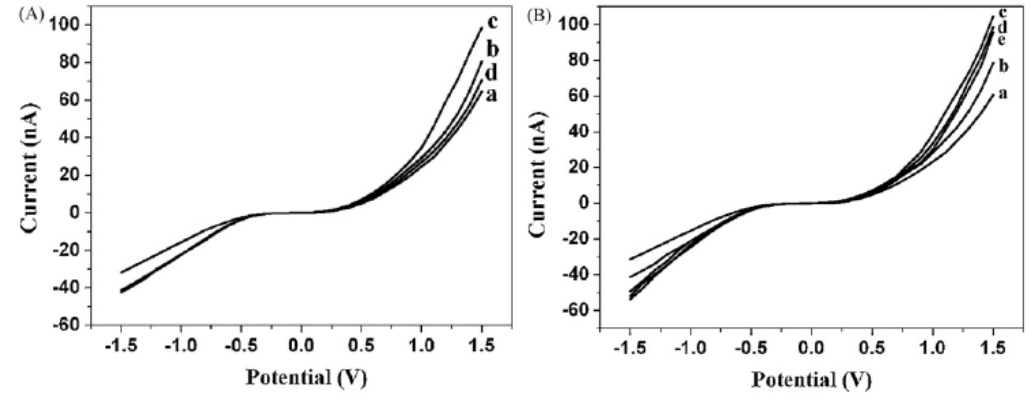
Figure 7. Electrical detection of DNA-EcoRI interaction: (A) I-V measurements for dsDNA cleavage by EcoRI: (a) bare sg-AuNPs, (b) sg-AuNPs with ss-DNA, (c) sg-AuNPs with ds-DNA, (d) dsDNA with EcoRI. (B) I-V measurements for assaying the cleavage specificity of EcoRI endonuclease: (a) bare sg-AuNPs, (b) sg-AuNPs with ss-DNA (probe DNA3), (c) sg-AuNPs with ds-DNA, (d) dsDNA with EcoRI, and (e) dsDNA with enzyme reaction buffer. Reprinted with permission from [86]. Copyright (2008) Elsevier B.V.